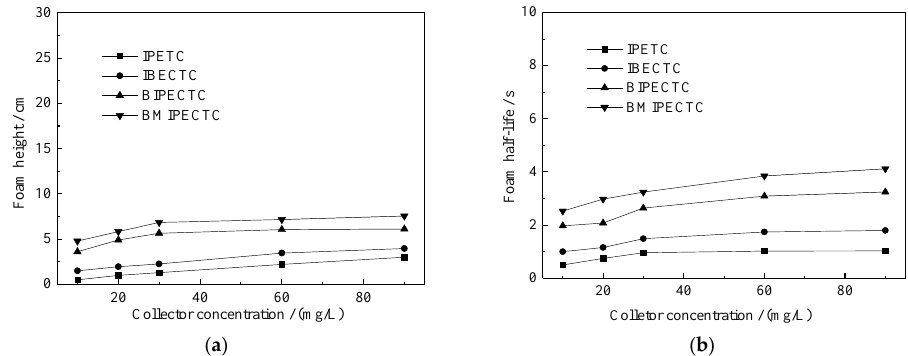
Figure 4. Maximum foam height and half-life as a function of the collector concentrations in slurry. ( a ) Foam heigh; ( b ) Foam half-life.